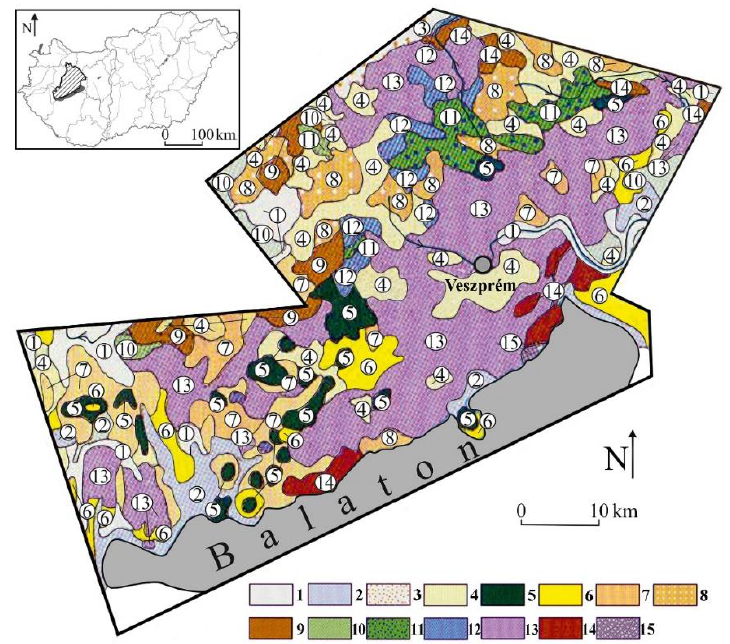
Figure 2. Geology of the Bakony Mountains [2]. Legend: 1. fluvial sediment, 2. Holocene torf, 3. Holocene wind-blown sand, 4. Pleistocene loess, 5. Pliocene basalt, 6. Upper-Miocene freshwater limestone, 7. Middle Miocene limestone, 8. Oligocene gravel, 9. Eocene limestone, 10. Upper Cretaceous limestone, 11. Lower Cretaceous limestone, 12. Jurassic limestone, 13. Triassic limestone, dolomite, 14. Permian sandstone, 15. old Paleozoic phyllite.